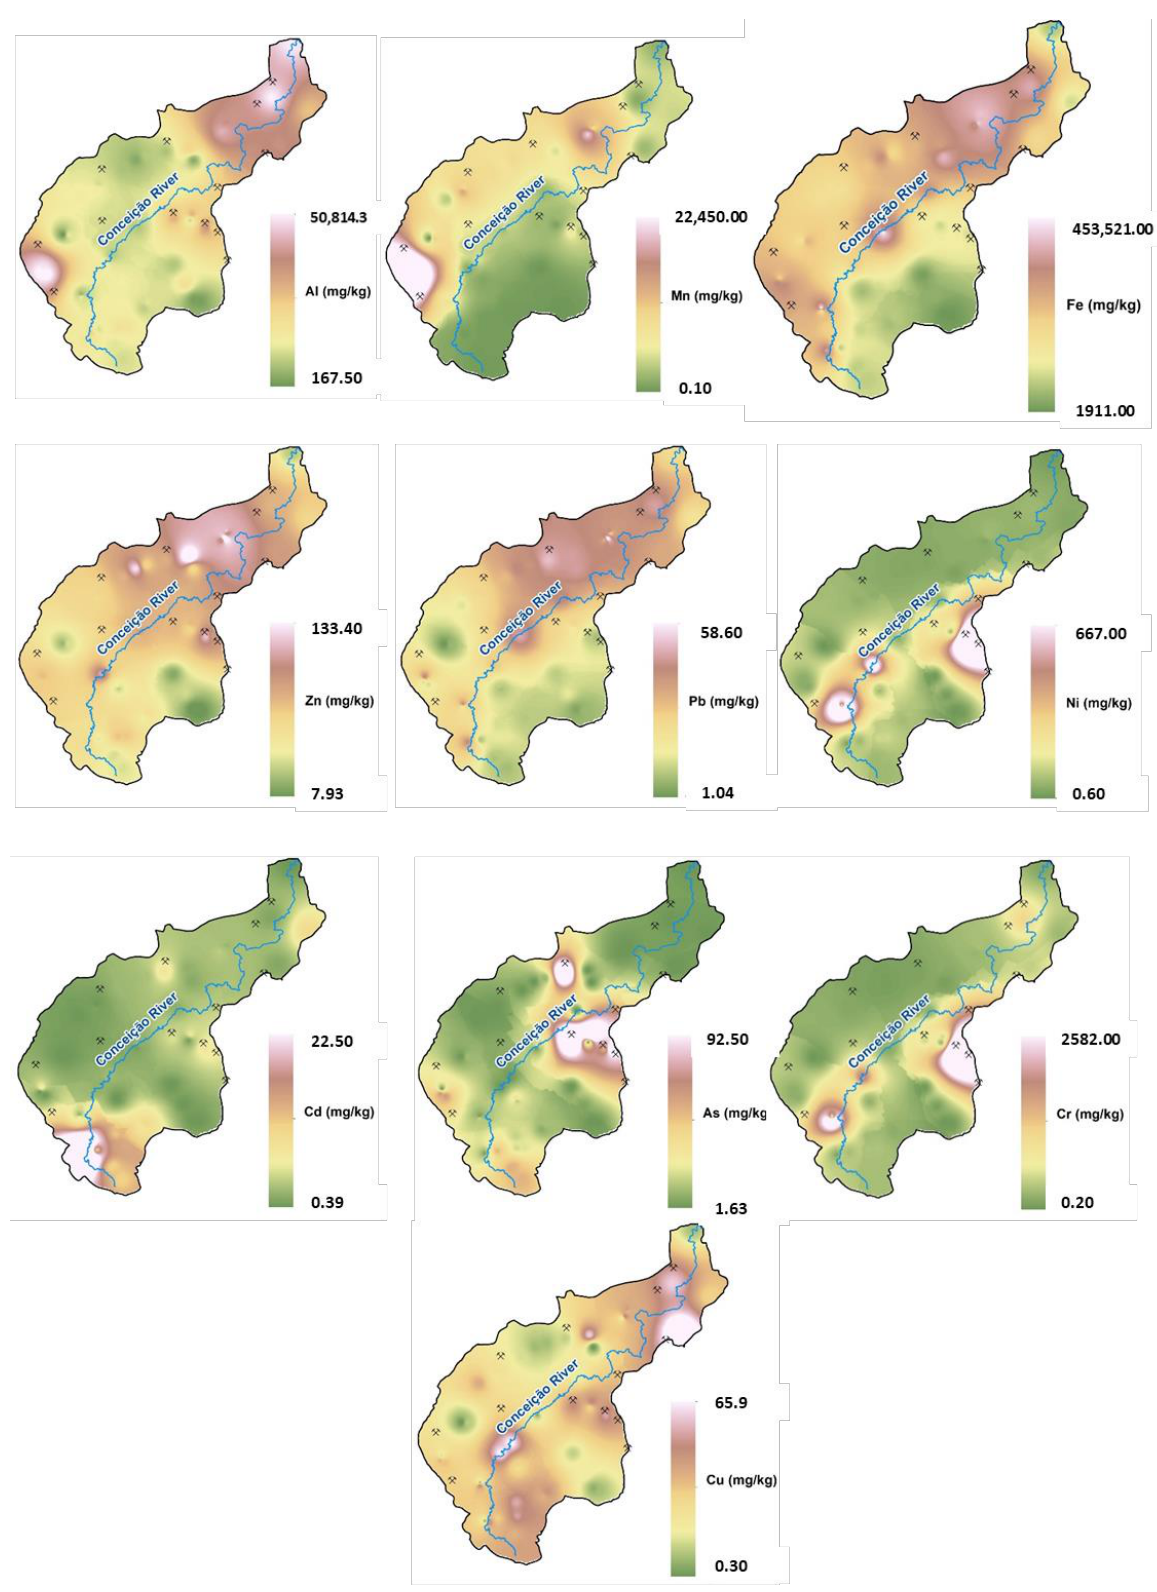
Figure 3. Trace element distribution in stream sediments of the Conceição river basin.